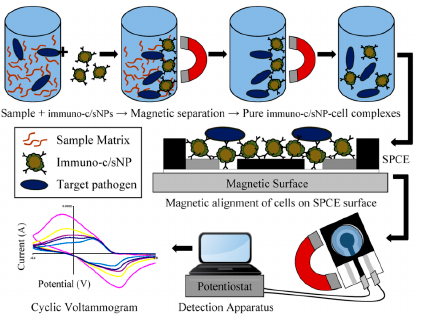
Figure 9. Schematic representation of the use of immuno-magnetic/polyaniline core/shell nanoparticle (c/sNP) with cyclic voltammerty for Bacillus and E. coli O157:H7 detection (adapted with permission from [17].